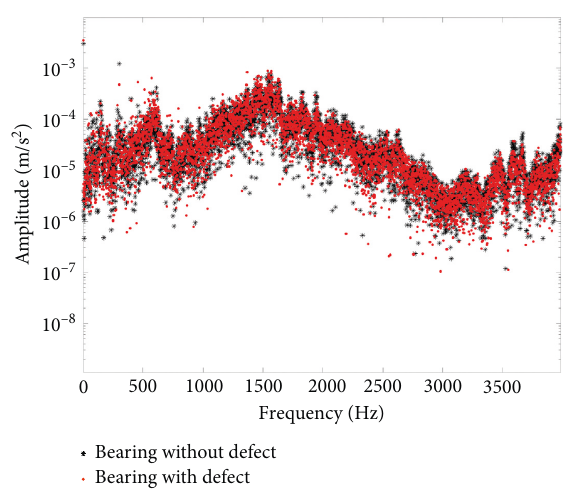
Figure 2: Harmonic content of the signals of bearing without and with defect. Table 3: Detection of the defect in the outer raceway (BPFO), based on the data processing of channels 1 and 2; list of detected